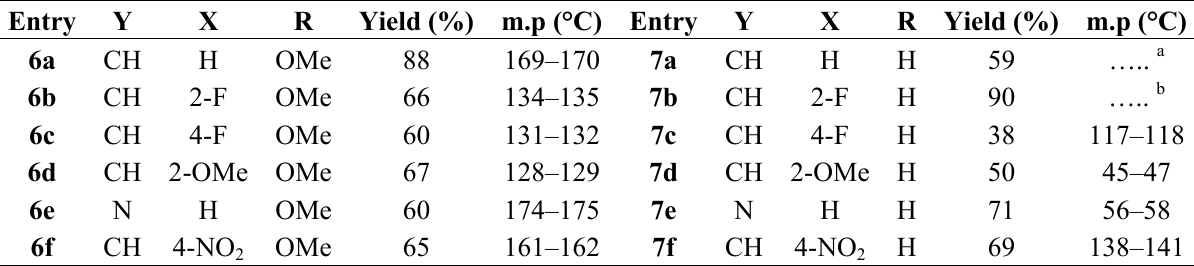
Table 1. Series ( 6a–f and 7a–f ) obtained through Michael addition reaction